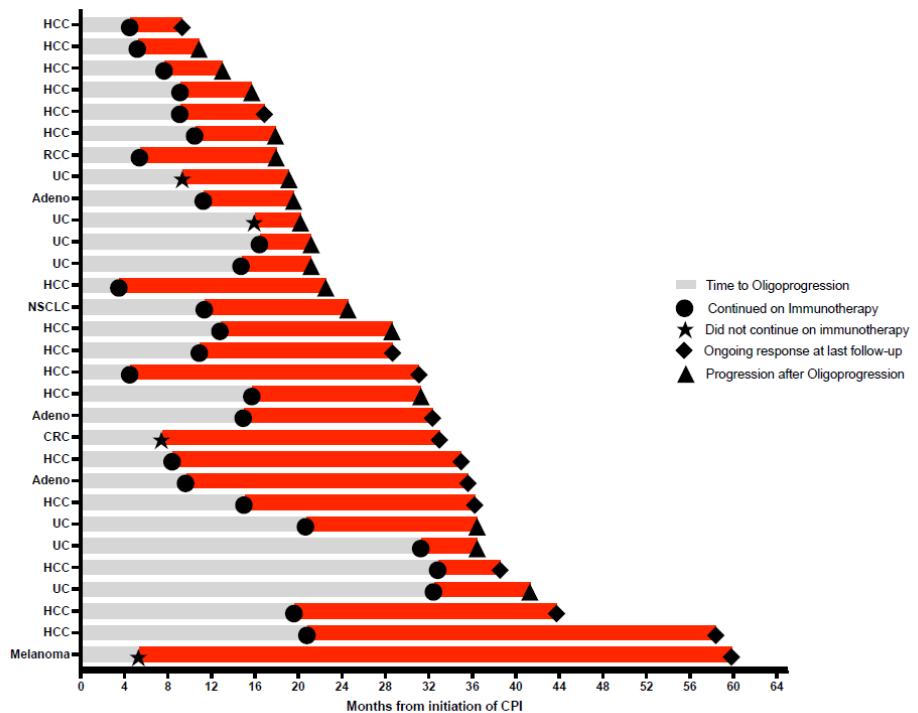
Figure 1. Disease courses in patients who achieved at least stable disease on ICIs for at least three months and then experienced oligoprogression. Adeno, adenocarcinoma; CRC, colorectal carcinoma; HCC, hepatocellular carcinoma; NSCLC, non-small cell lung cancer; RCC, renal cell carcinoma; UC, urothelial carcinoma.